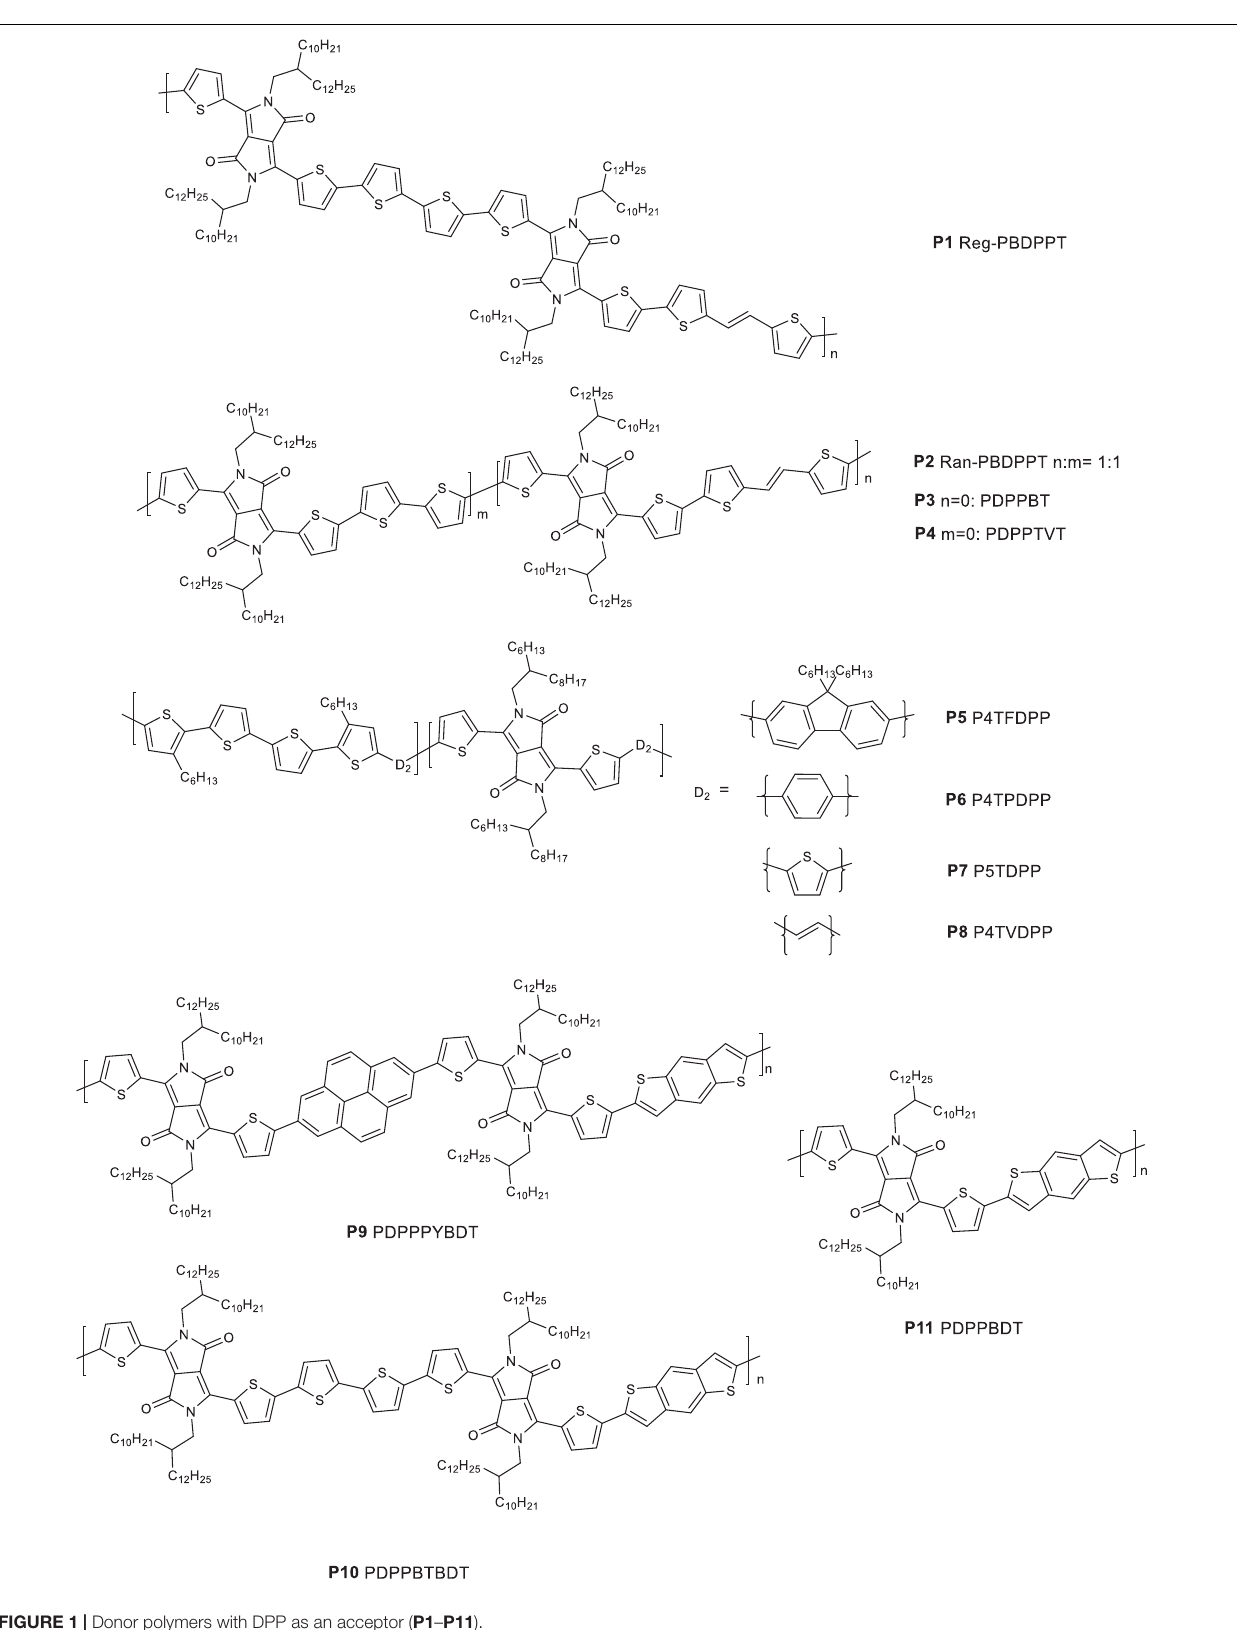
Frontiers in Materials |